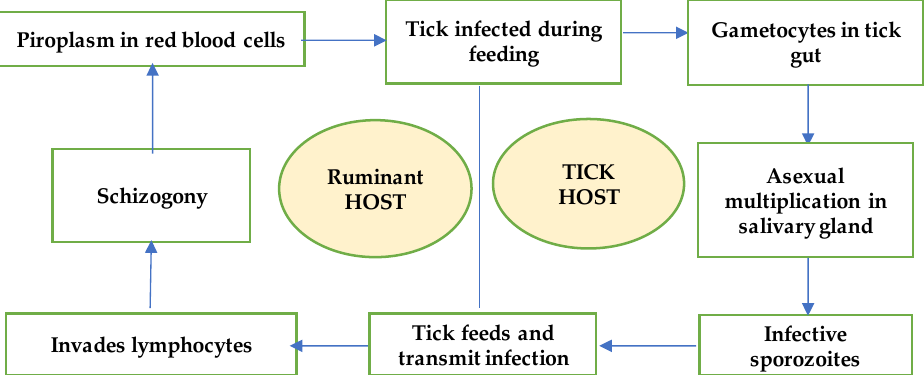
Figure 1. Life cycle of Theileria showing different stages in ruminants and tick hosts.